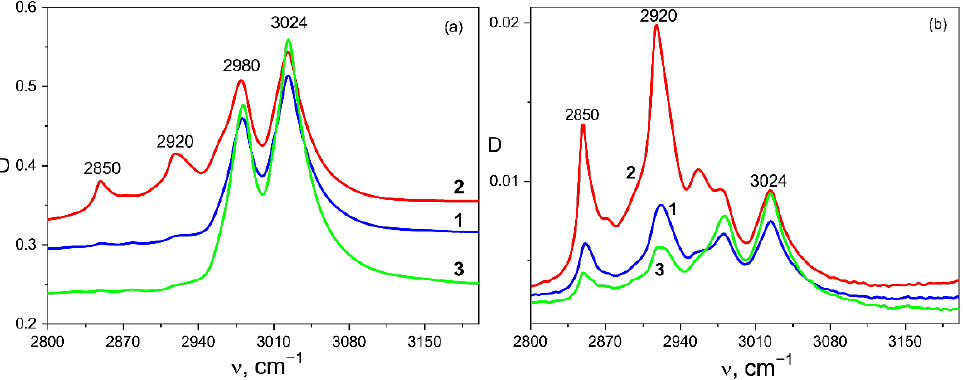
Figure 3. Vibrational bands in the valence vibration region of C – H groups for P(VDF-HFP) copoly- mer films crystallized from acetone without doping 1 — and with different dopants: 2 — TPP, 3 — films crystallized from acetone without doping 1—and with different dopants: 2—TPP, 3—ZnTPP; ZnTPP; ( a ) transmission mode, ( b ) ATR mode. ( a ) transmission mode, ( b ) ATR